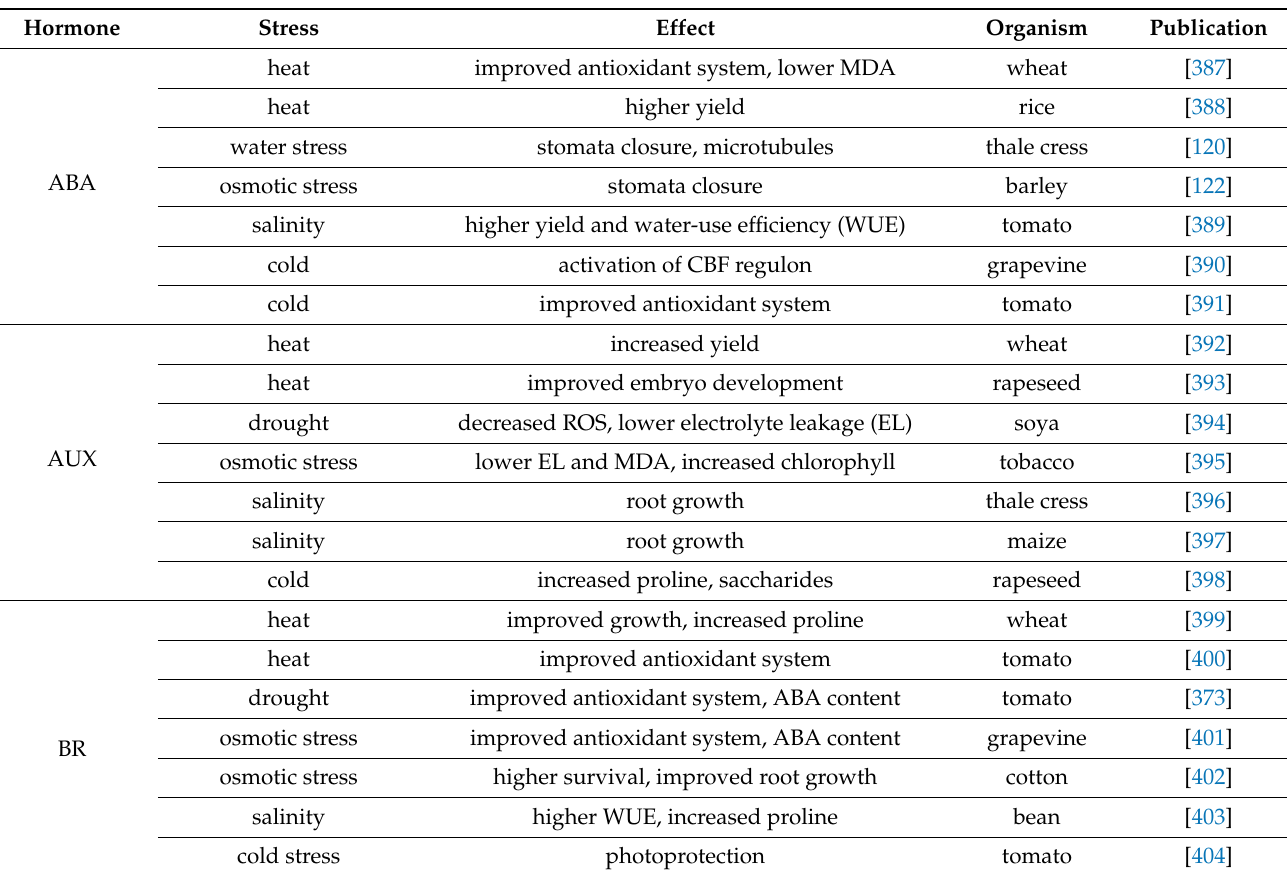
Table 3. Role of phytohormones in abiotic